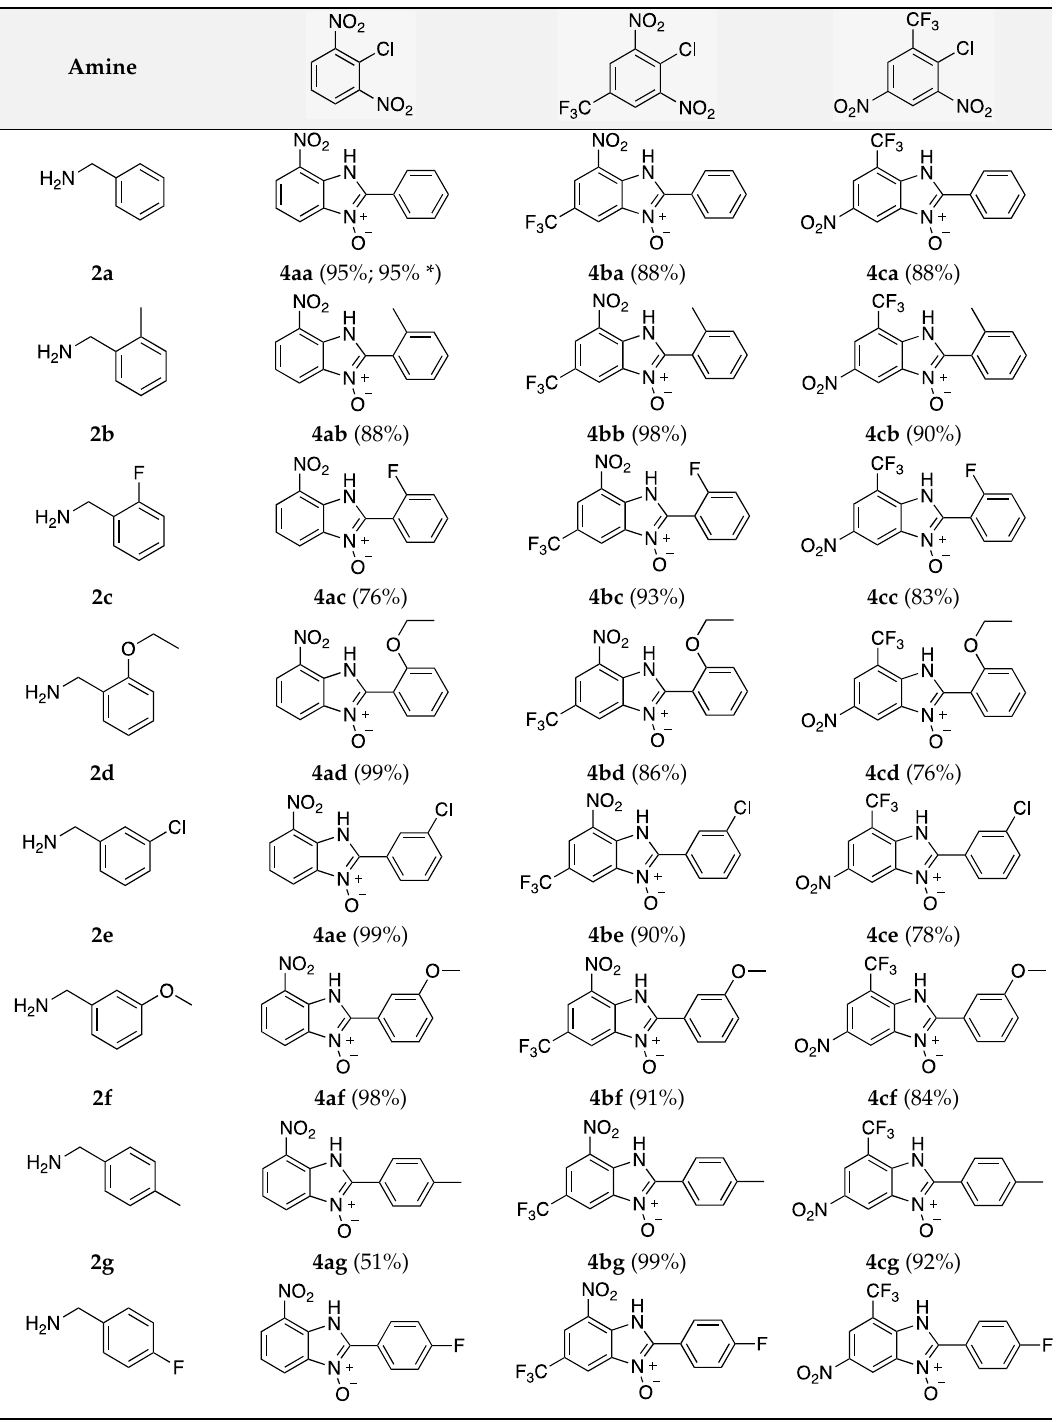
Table 2. The library of 2-aryl-benzimidazole 3-oxides prepared in this study a .